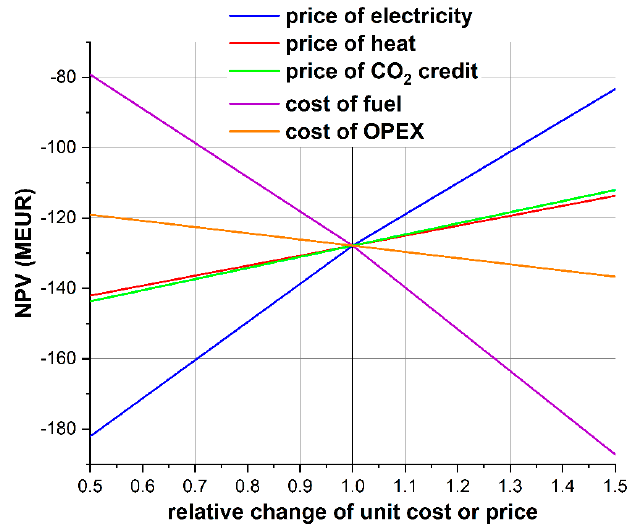
Figure 13. Sensitivity analysis in the business as usual scenario in the analyzed system.